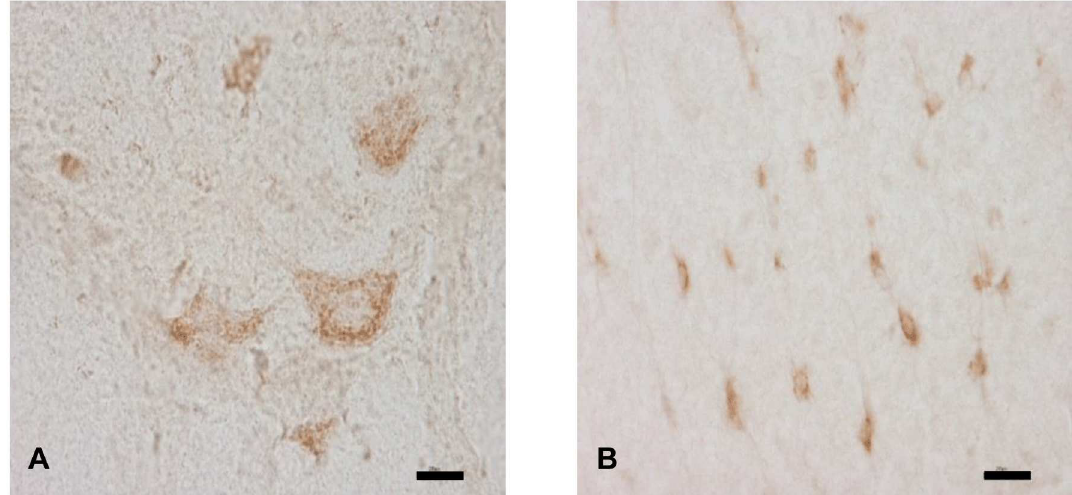
Fig 3. Immunohistochemistry for TRIB3 in the dmy rat. The immunohistochemistryfor TRIB3 in the lumbar spinal cords from dmy rats at 7-week-old. Cytoplasmof neuronsand glial cells are stained with TRIB3 in the gray (A) and white matter (B) of the dmy rats. Bars: 20 μ